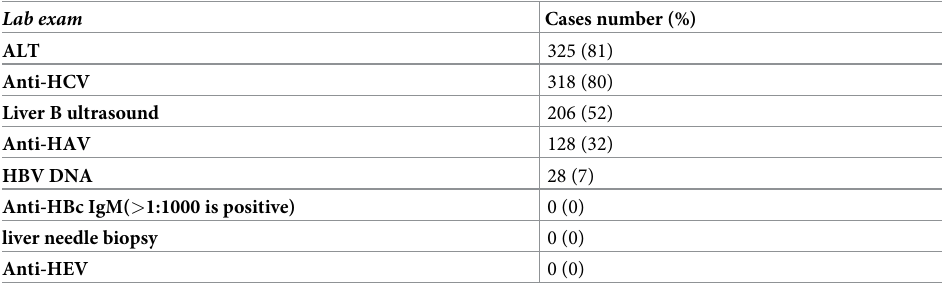
Table 2. Laboratory diagnostic tests in 400 cases of hepatitis B reported in